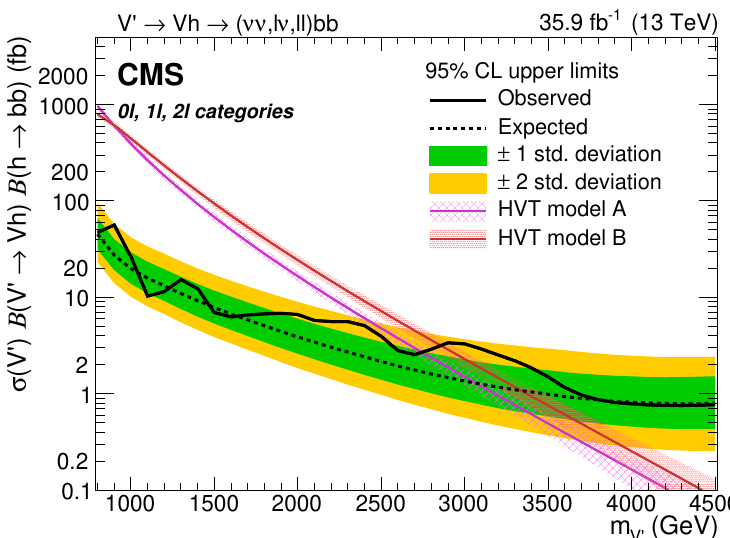
Figure 6 . Observed and expected 95% CL upper limit on (cid:27) (X) function of the HVT triplet mass, for the combination of all the considered channels. The inner green and outer yellow bands represent the expected limit. The solid curves and their shaded areas correspond to the cross sections predicted by the HVT models A and B and the relative